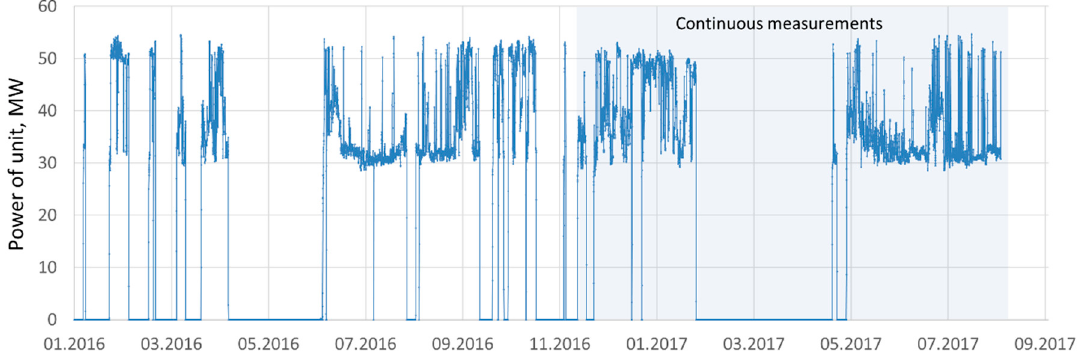
Figure 8. The electric power of the unit during the eighteen month operation period (which correlates with changes in boiler capacity). The dark background color indicates the period when O 2 and CO measurements were recorded.